Question: State the chart type depicted above.
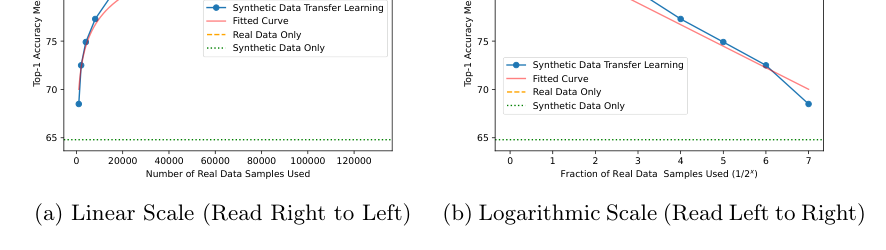
Answer: line